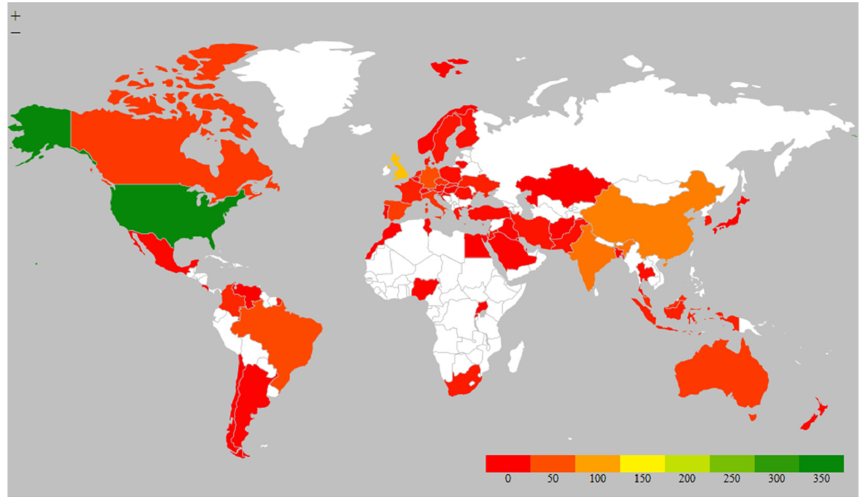
Figure 7. Visual Map of Prominent Institution’s Collaboration on EVA Research.